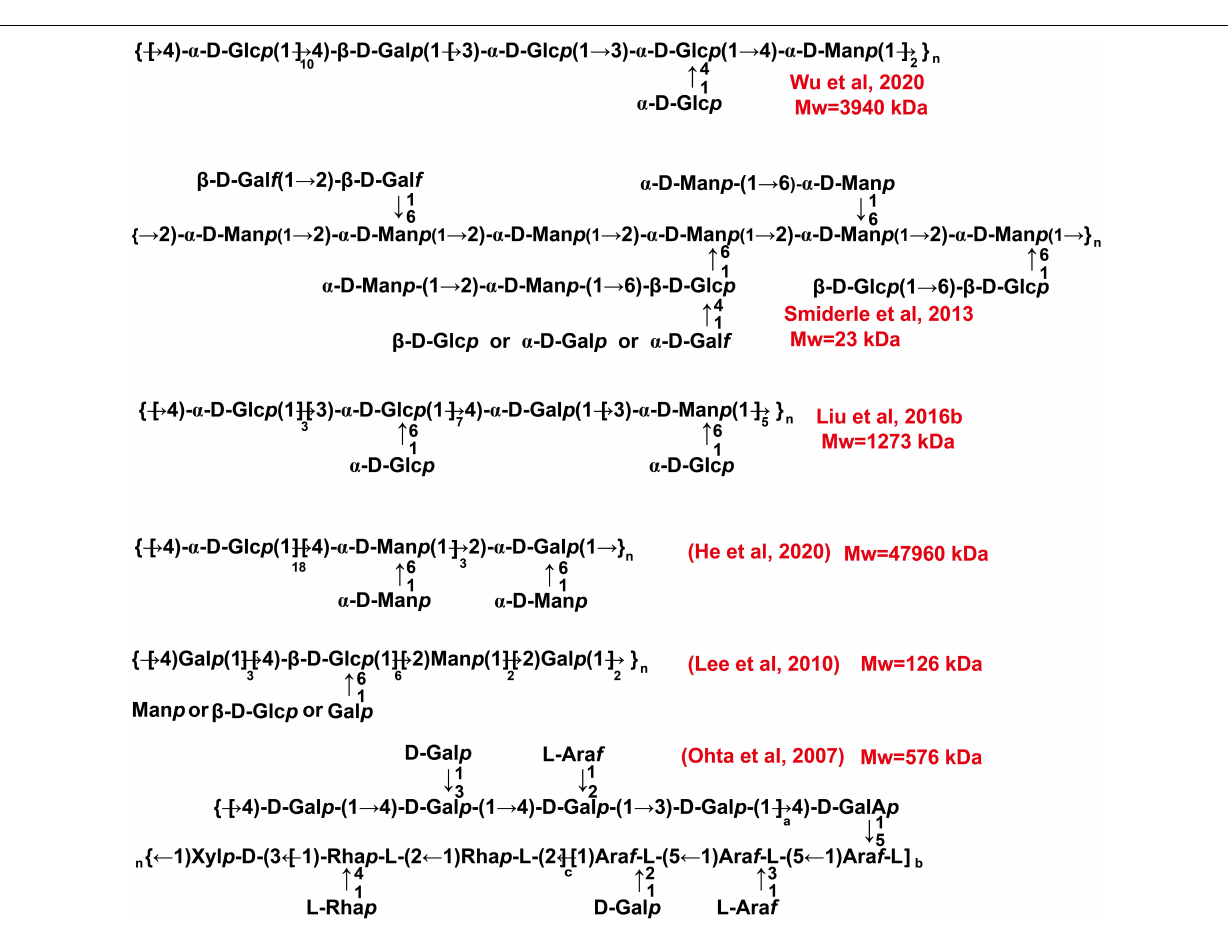
FIGURE 7 | The chemical structures of polysaccharides derived from the fruiting body of C. militaris . We presumed these structures according to the descriptions in the